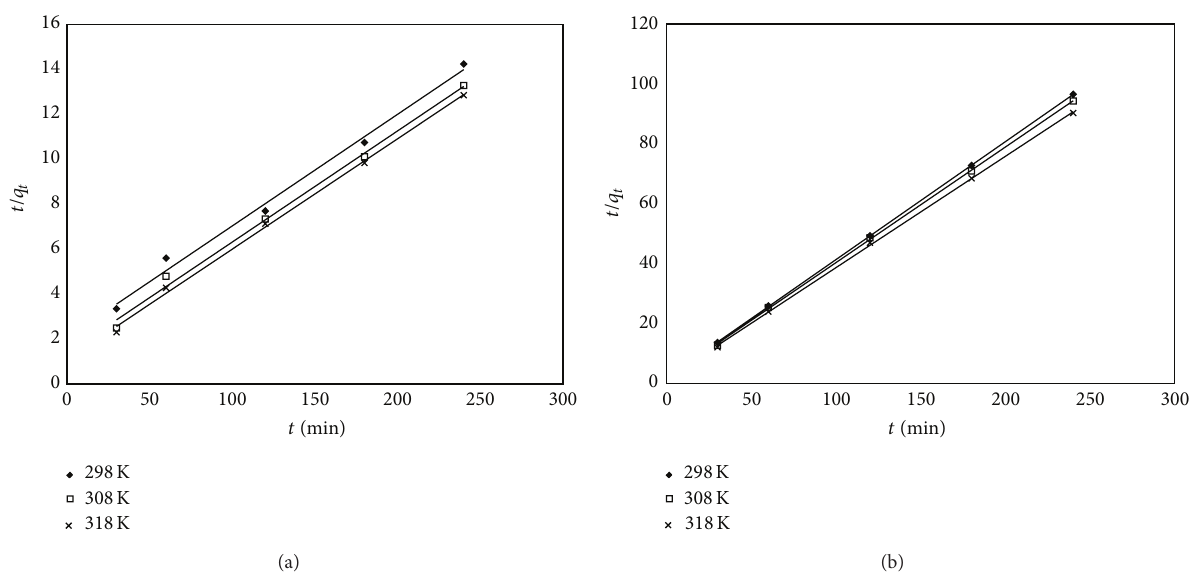
Figure 7: Pseudo-second-order kinetic plots for silica (a) and florisil (b) at the adsorption of As(V).